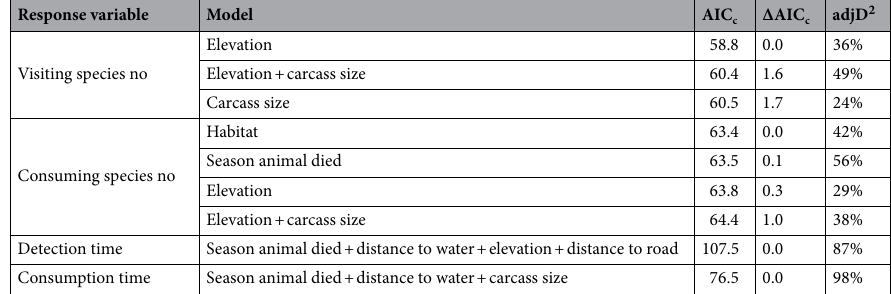
Table 1. AIC c -based model selection to assess the effects of carcass habitat, elevation, seasonality, carcass species, carcass body mass, and distance to both water and roads on scavenger guild numbers and scavenging efficiency at carcass sites in southwestern Montana. Highest ranking models are shown as well as those models with a ΔAICc < 2. The quantity adj D 2 is the percent deviance explained by each model.